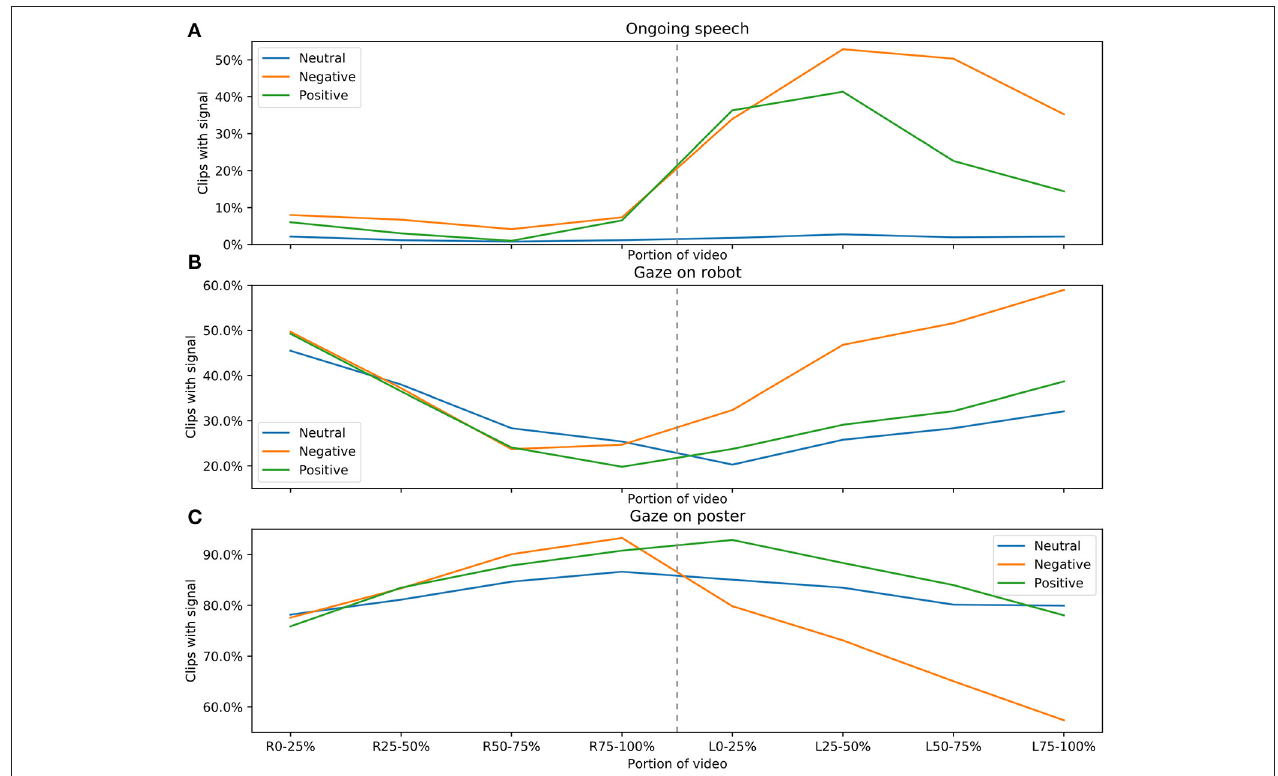
FIGURE 4 | (A–C) Where in the clips that the features ongoing speech , gaze on robot , and gaze on poster , from top to bottom, as described in section 3.3, appear. The horizontal axis has been normalised and split into two parts; on the left, the part of the clip where the robot speaks is represented with four points, representing whether the signal appears in the first 25 % of the robot’s speech, between 25 and 50 % , between 50 and 75%, and finally for the last 25 % of the part of the clip where the robot speaks. The same split is done for the part of the clip where the robot does not speak, which is similarly represented on the right half of the horizontal axis. The vertical axis shows how many of the clips that are marked as positive, negative, and neutral that contain the signal in that span. Note that all three Y axes are clipped to make the comparison between neutral, negative and positive clips clearer.